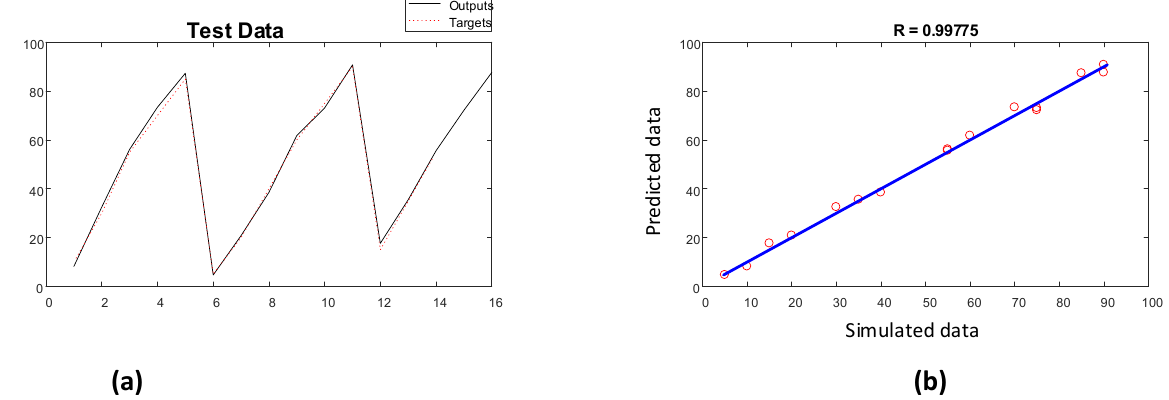
Figure 12. Performance of void fraction estimator network (testing): ( a ) fitting diagram and ( b ) regression diagram. The obtained errors of the proposed artificial neural network model are shown in Table 3, where the MRE% and RMSE values were calculated using Equations (9) and (10),